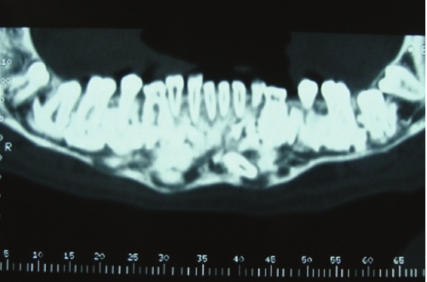
Figure 6: CT scan showing sections of lesion in the periapical region (Case 1).